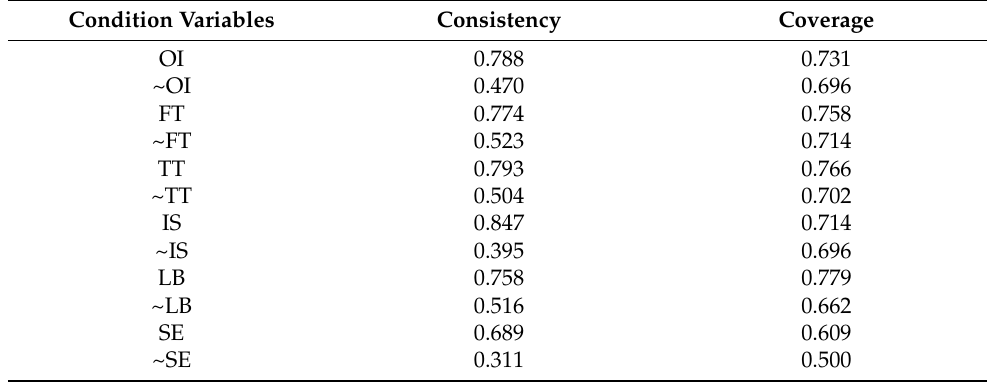
Table 4. Analysis of necessary